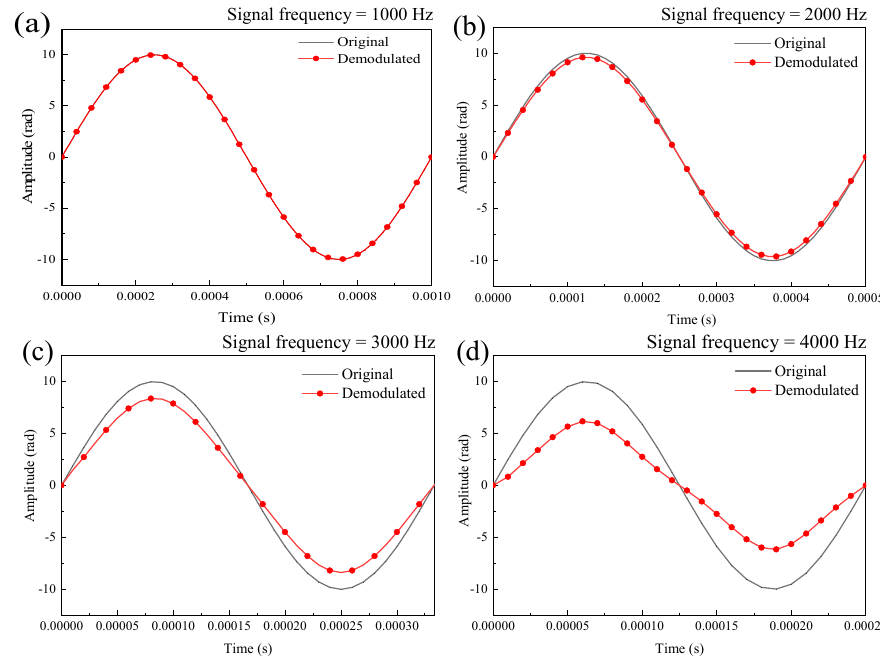
Figure 3. Simulation of demodulated signals at signal frequencies of 1000 Hz ( a ), 2000 Hz ( b ), 3000 Hz ( c ), 4000 Hz ( d ).